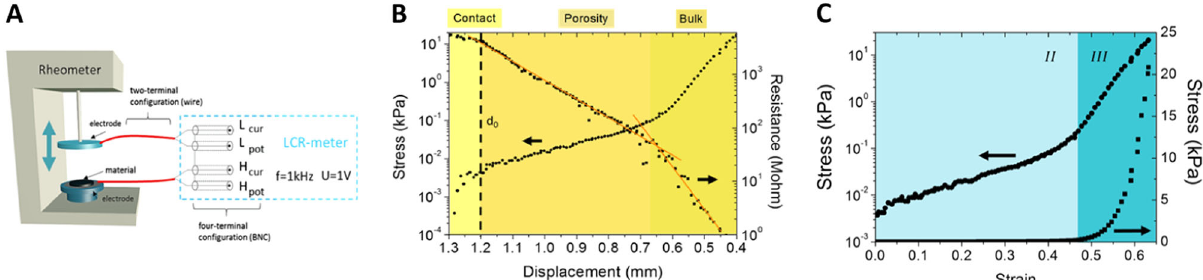
Fig. 2 a Schematic representation of the experimental set-up for sensitivity measurements. The bilayer material is placed between the two stainless electrodes, the bottom electrode is at rest while the top electrode can be moved. Rheometer is used as mechanized z -axis stage and force gauge. Dielectric properties are measured using an LCR-meter at 1 kHz and a bias of 1 V. b Evolution of the stress and the electrical resistance R as function of the displacement, 10 wt% CB bilayer material. c Stress – strain curve after 100 cycles, 10 wt% CB bilayer material. Pressure ranges are highlighted by blue increments: blue II (0 – 0.2 kPa), blue III (0.2 – 20